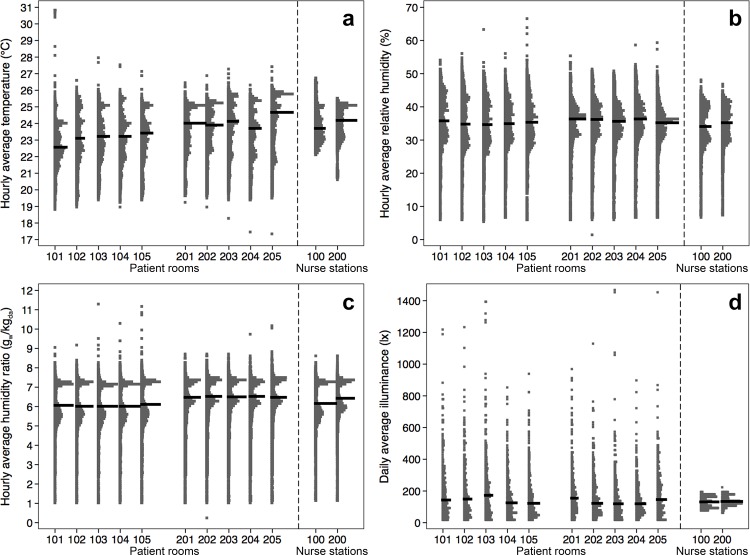
Distribution dot plots for four measured environmental conditions in the hospital: (a) hourly average air temperature, (b) hourly average relative humidity, (c) hourly average humidity ratio, and (d) daily average illuminance levels.Rooms 101–105 are on the 9th floor; rooms 201–205 are on the 10th floor. Room 100 and 200 are the nurse station locations on the 9th and 10th floor, respectively. The horizontal black bar represents the median hourly values (only daily averages are provided in part (d) for better graphical clarity).